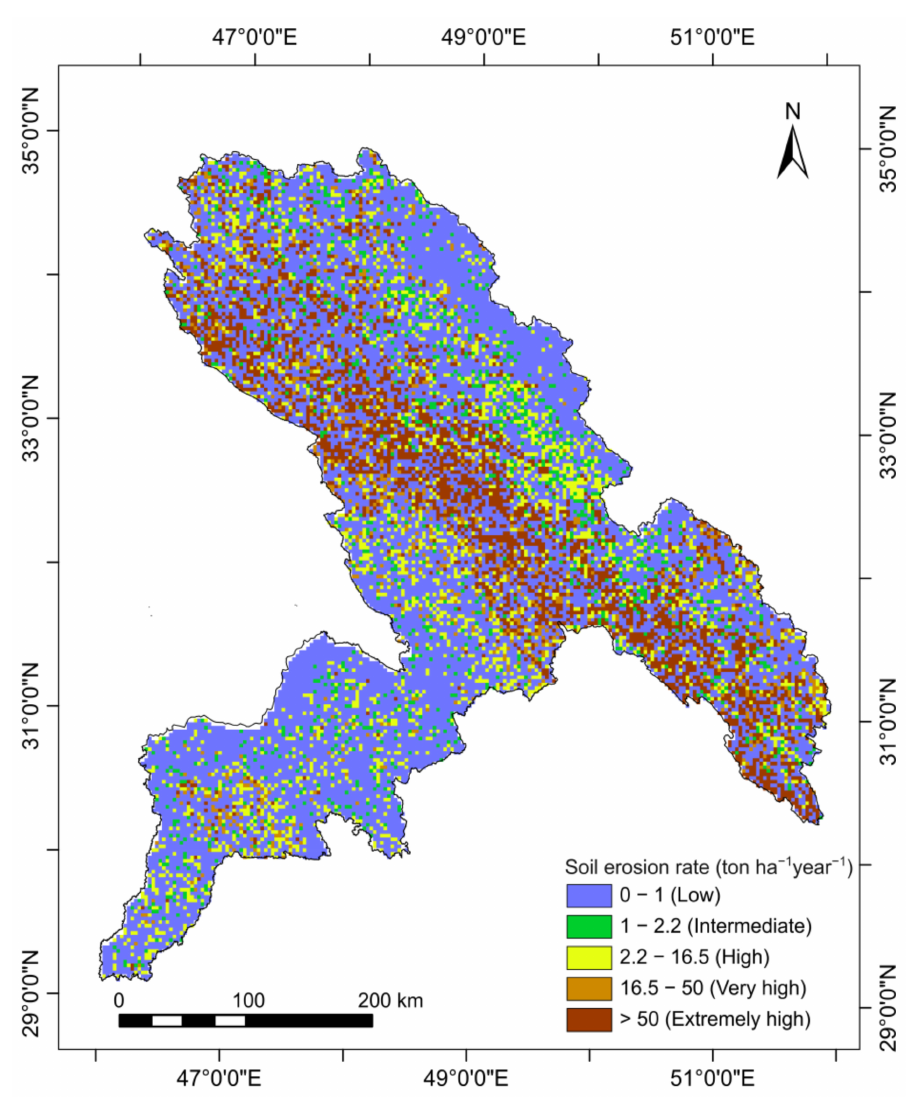
Figure 8. Soil erosion rate distribution in the Shatt Al-Arab